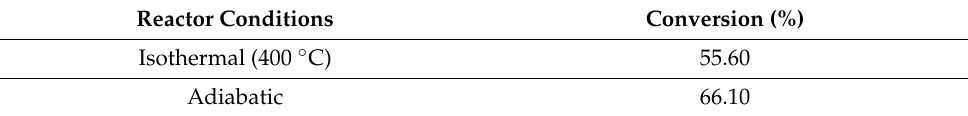
Table 1. Results obtained for isothermal and adiabatic reactor conditions.